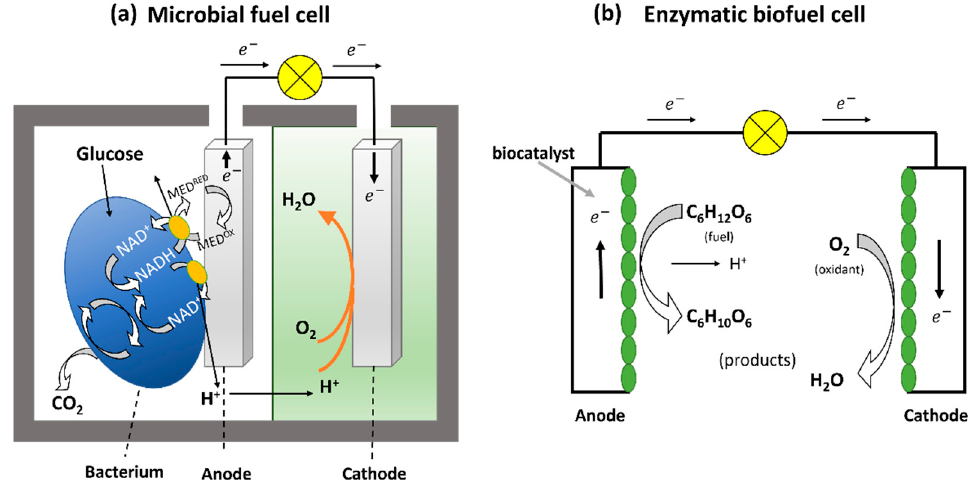
Figure 3. Basic operating principle of ( a ) microbial BFC [25] and ( b ) enzymatic BFC [26]. Zhang et al. [27] were able to exploit an enzymatic BFC, which was integrated into a diaper of diabetic patients, as an effective glucose concentration sensor while simultane- ously powering the system. Quantitatively, they managed to approach a power density of 220 μ Wcm − 2 . Zhang et al. [28] took a rather unconventional approach and designed an artificial enzyme which mimics its natural competitor with a power density of 149.2 ± 4.0